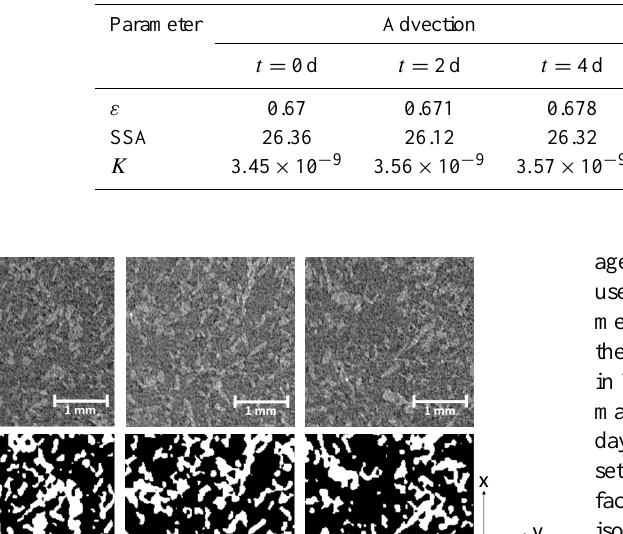
Table 3. Morphological and flow characteristics of a snow sample with and without advection.